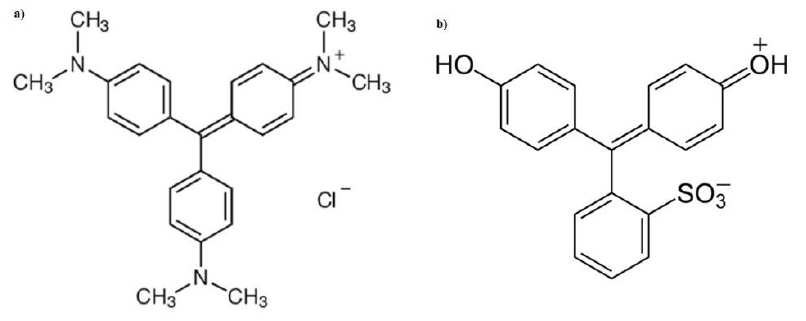
Figure 1. Chemical structure of: ( a ) Gentian Violet and ( b ) Phenol red [8,16].